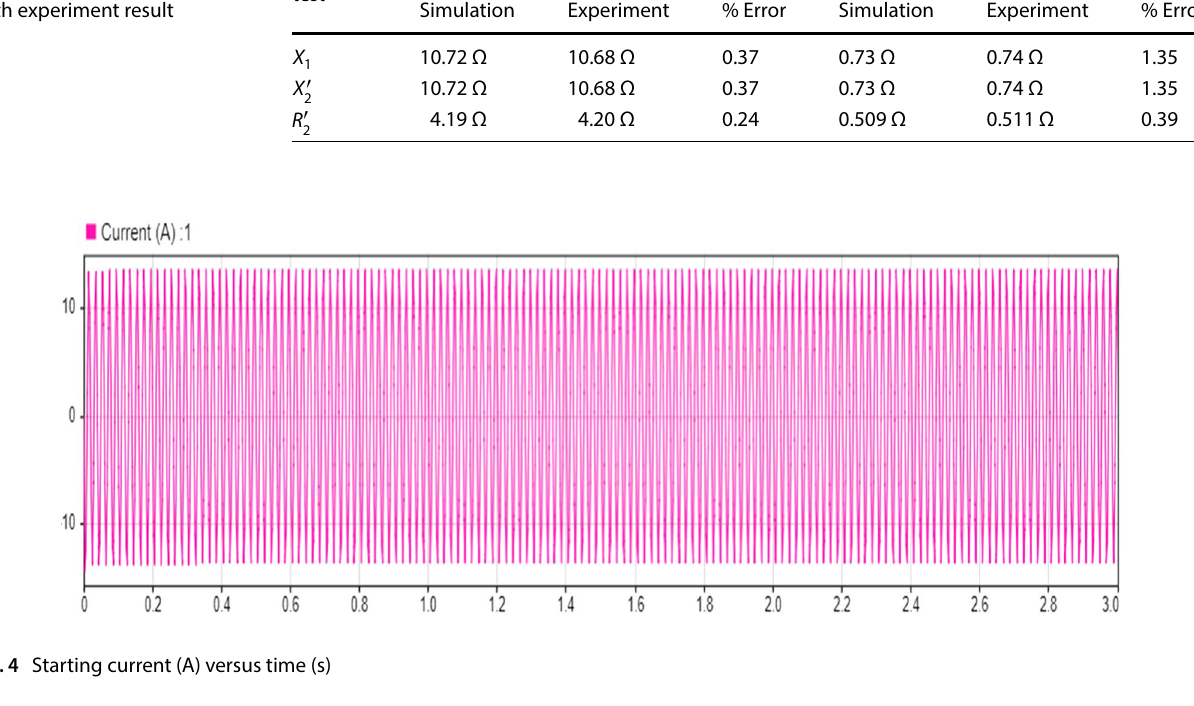
Table 7 Comparison of locked rotor test simulation result with experiment result